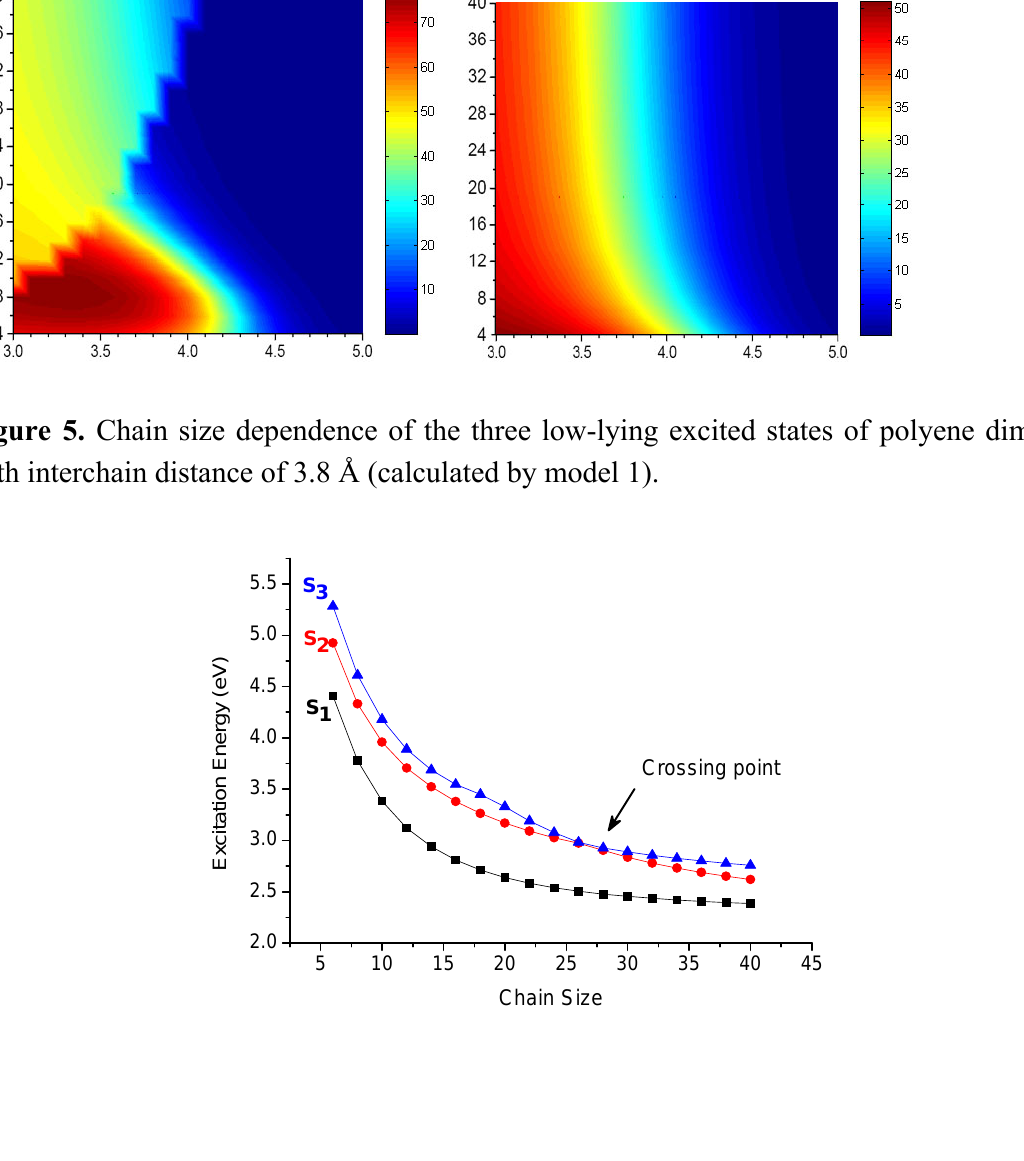
Figure 4. Contour polts of the CT exciton (in percentage) as a function of interchain distance (x axis) and chain size (y axis) of the first (right) and second (left) excited states in polyene dimers calculated using model 1 [46]. Reproduced with permission from American Chemical Society.